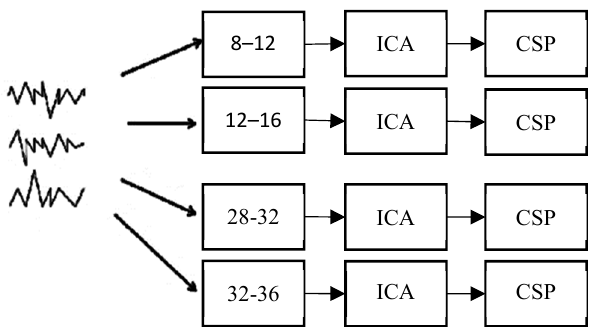
Figure 1. Division of signals into subsignals by filtering followed by the application of spatial filters, as described by [14]. CSP: common spatial pattern.